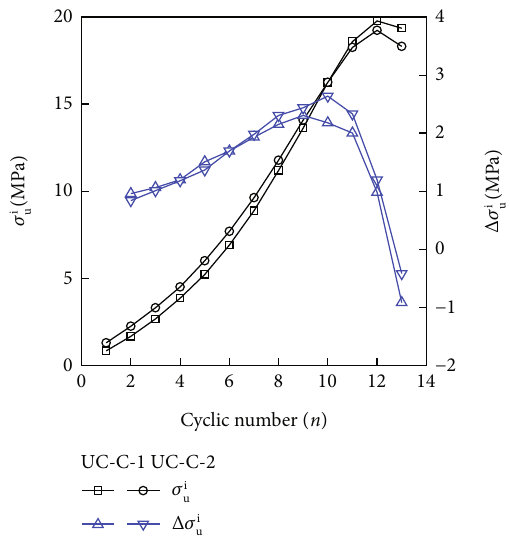
Figure 4: Unloading stress level and its di ff erence of sandstone under cyclic